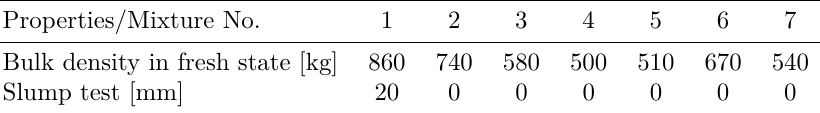
Table 2. Properties of the lightweight concrete in fresh state.